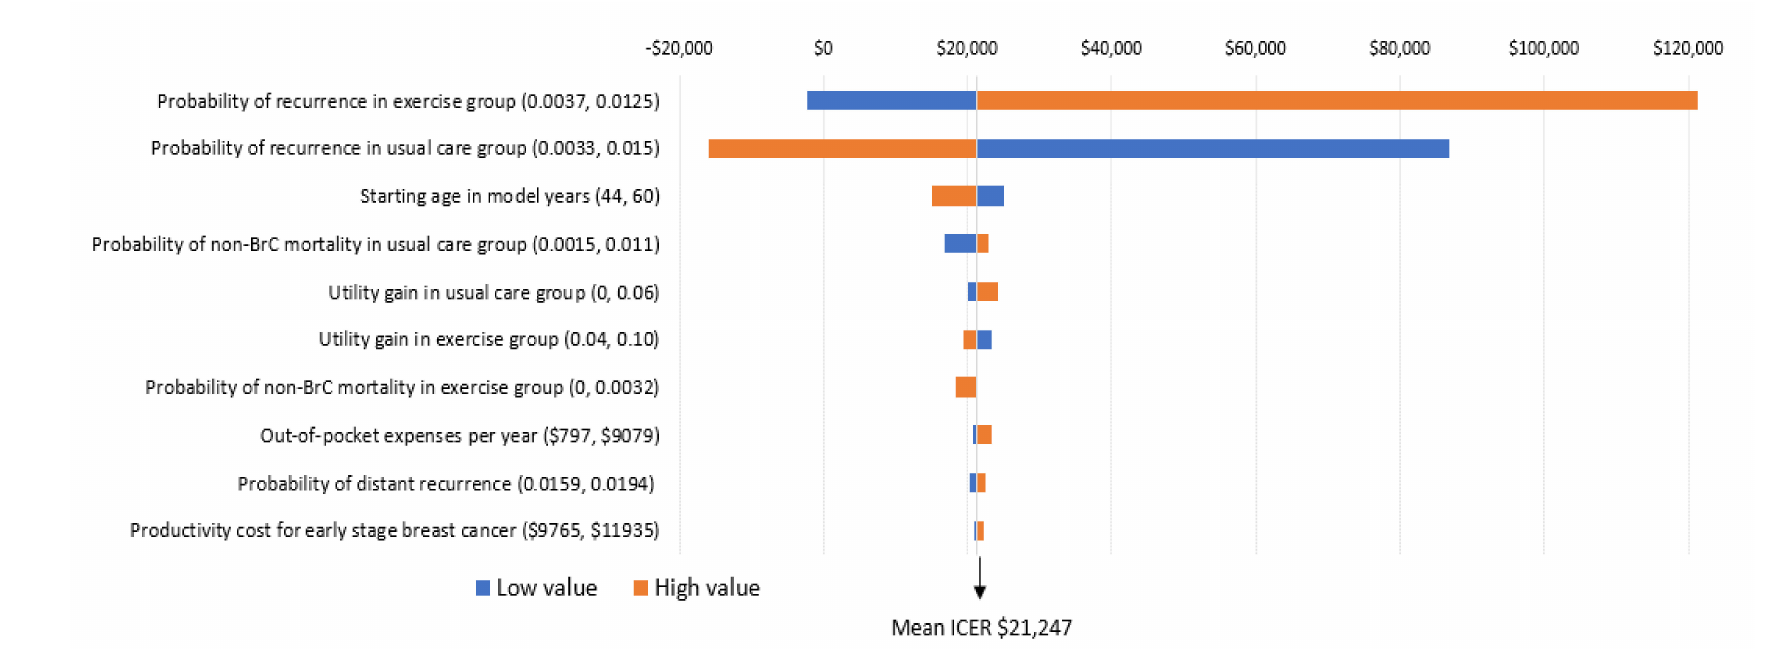
Figure 4. One-way sensitivity analyses; incremental cost per QALY